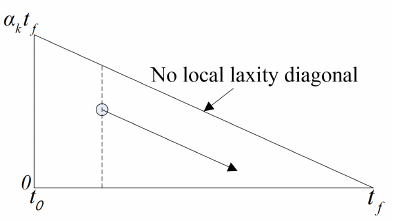
Figure 3. Transistion of the T-L plane (frequency = α k